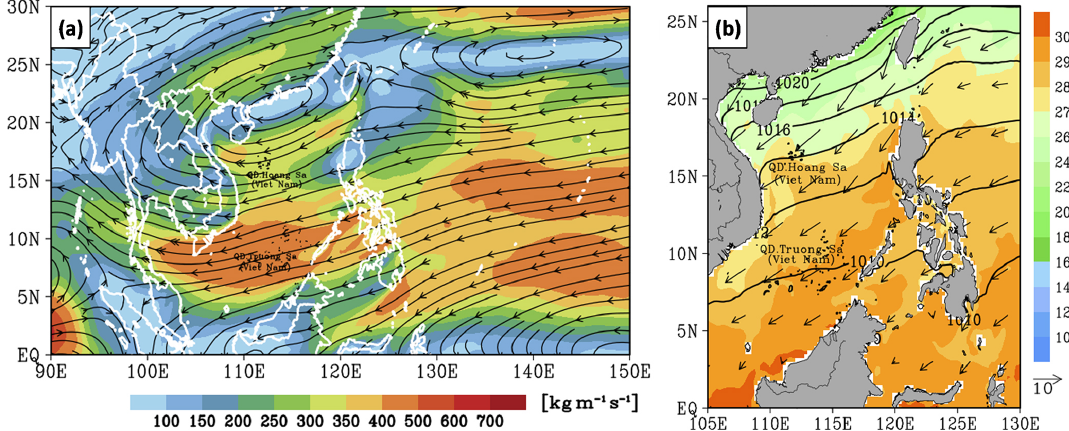
Figure 5. (a) The ERA5 averaged surface and 200hPa vertically integrated moisture flux (kgm − 1 s − 1 ). (b) The ERA5 averaged SST ( ◦ C, color), mean sea-level pressure (hPa, isobars, every 2hPa), and horizontal wind vectors at 10m height (ms − 1 , vector), from 00:00UTC on 8 December to 18:00UTC on 11 December 2018.